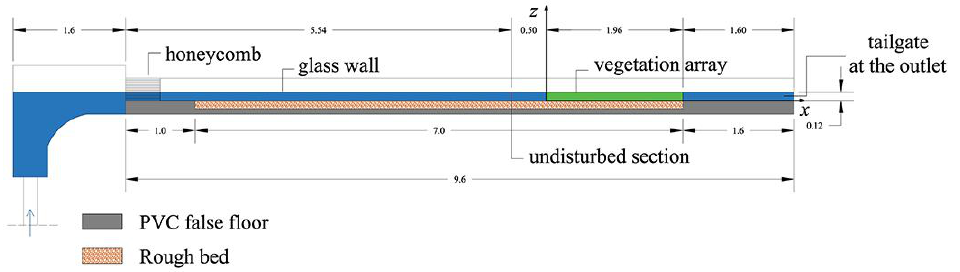
Figure 1. Schematic of the experimental facility (dimensions are expressed in meters). The experiments were carried out with a flow depth h ≈ 0.12 m, measured 50 cm upstream of the vegetation array (i.e., in undisturbed flow condition) by a point gauge with a decimal Vernier having an accuracy of ± 0.1 mm and a flow discharge Q equal to 19.73 L/s (measured with a Thomson weir). The approaching cross-section average flow velocity U = Q /( Bh ) was, hence, equal to 0.30 m s − 1 , where B was the flume width. The longitudinal bottom slope of the flume, S , was fixed at 1.5‰ using a hydraulic jack. The rigid vegetation was simulated with vertical, wooden and circular cylinders. The cylinder height and diameter were h c = 0.40 m and d = 0.02 m, respectively. The stems were implanted into a 1.96-m long, 0.485-m wide and 0.015-m thick Plexiglas panel fixed to the channel bottom. A total of 68 cylinders were randomly arranged in the flume (Figure